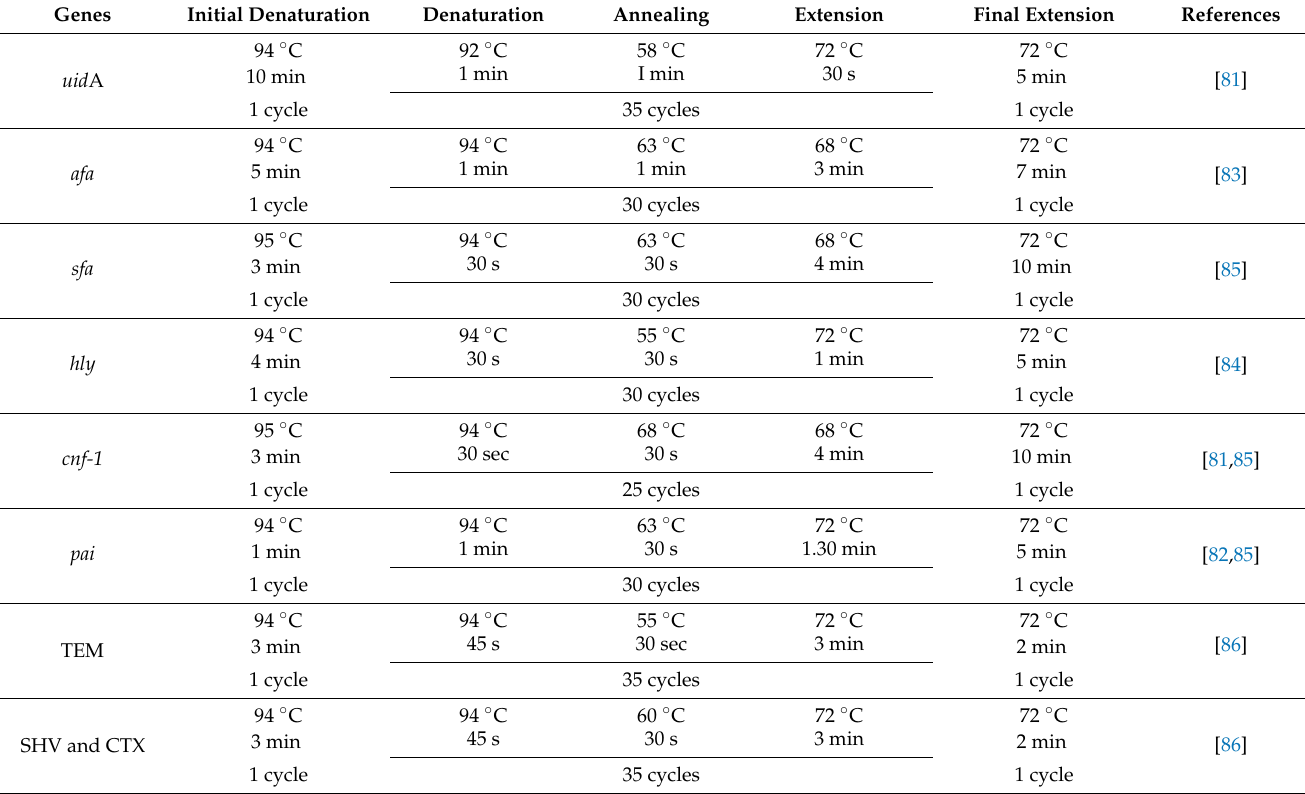
Table 3. The PCR amplification condition for detecting different gene markers in this